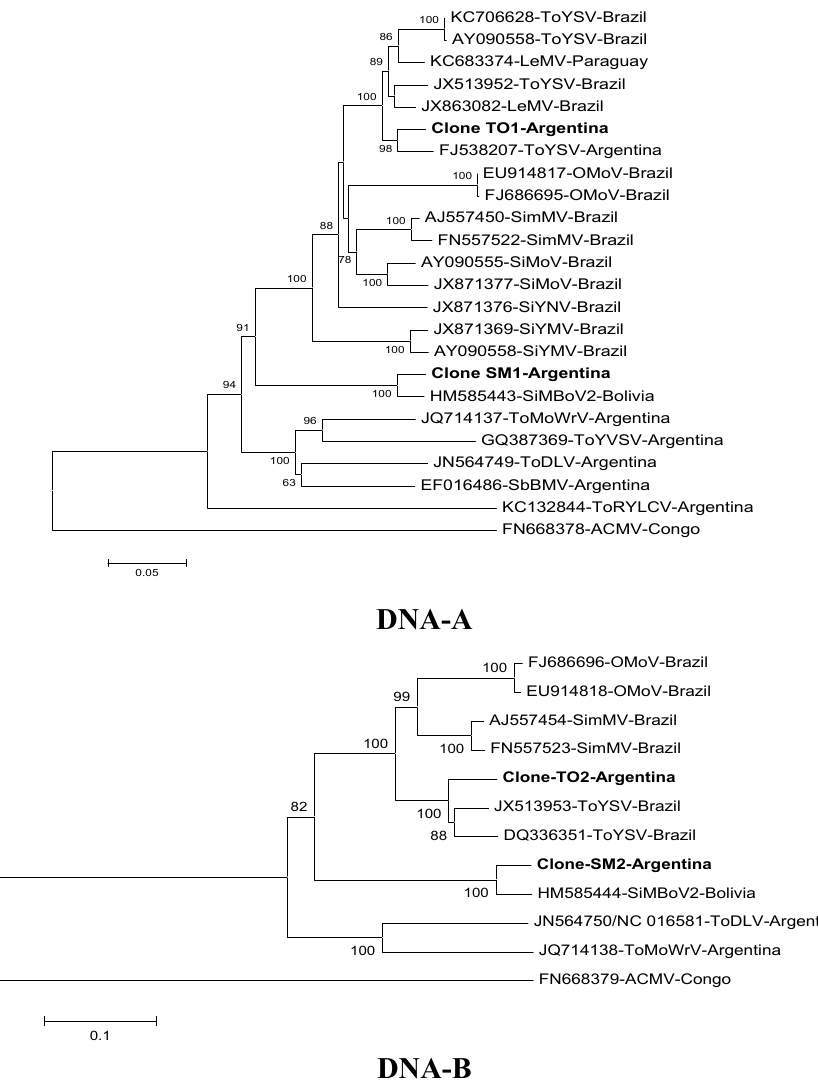
Figure 2. Neighbor-joining trees showing the phylogenetic relationship between DNA-A and DNA-B of the isolates detected in this study and other begomoviruses and from the international database GenBank [17] and using African cassava mosaic virus (ACMV) as an outgroup. Numbers next to the branch points indicate bootstrap values (1,000 replicates) above 50% (0.5). SbBMV, ToYVSV, ToDLV, SPLCV, ToMoWrV, ToRYLCV,